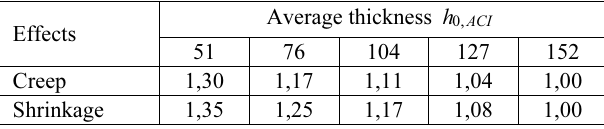
Table 2. Correction factor accounts size and shape of the mem- ber for deriving creep and